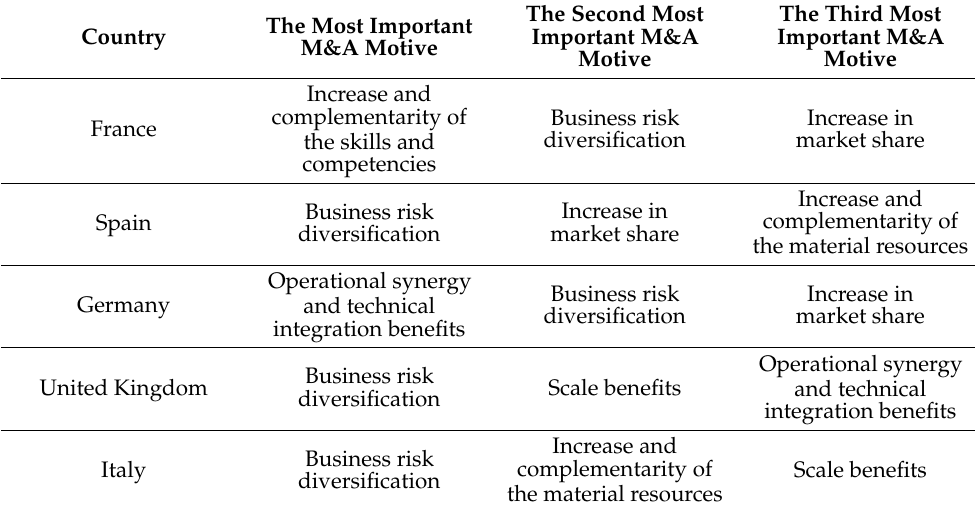
Table 3. The most important M&A motives identified in M&A transactions in the research sample, grouped by country. The Second Most The Most Important Country Important M&A Motive